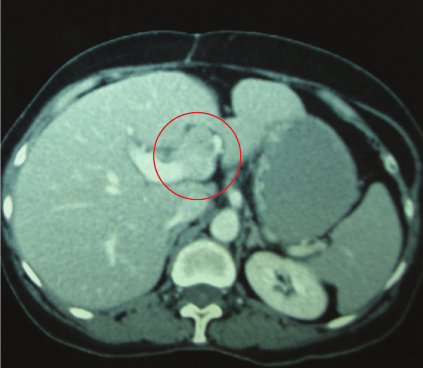
Figure 1: CT scan showing mass lesion in segment 4 abutting the left branch of portal vein.